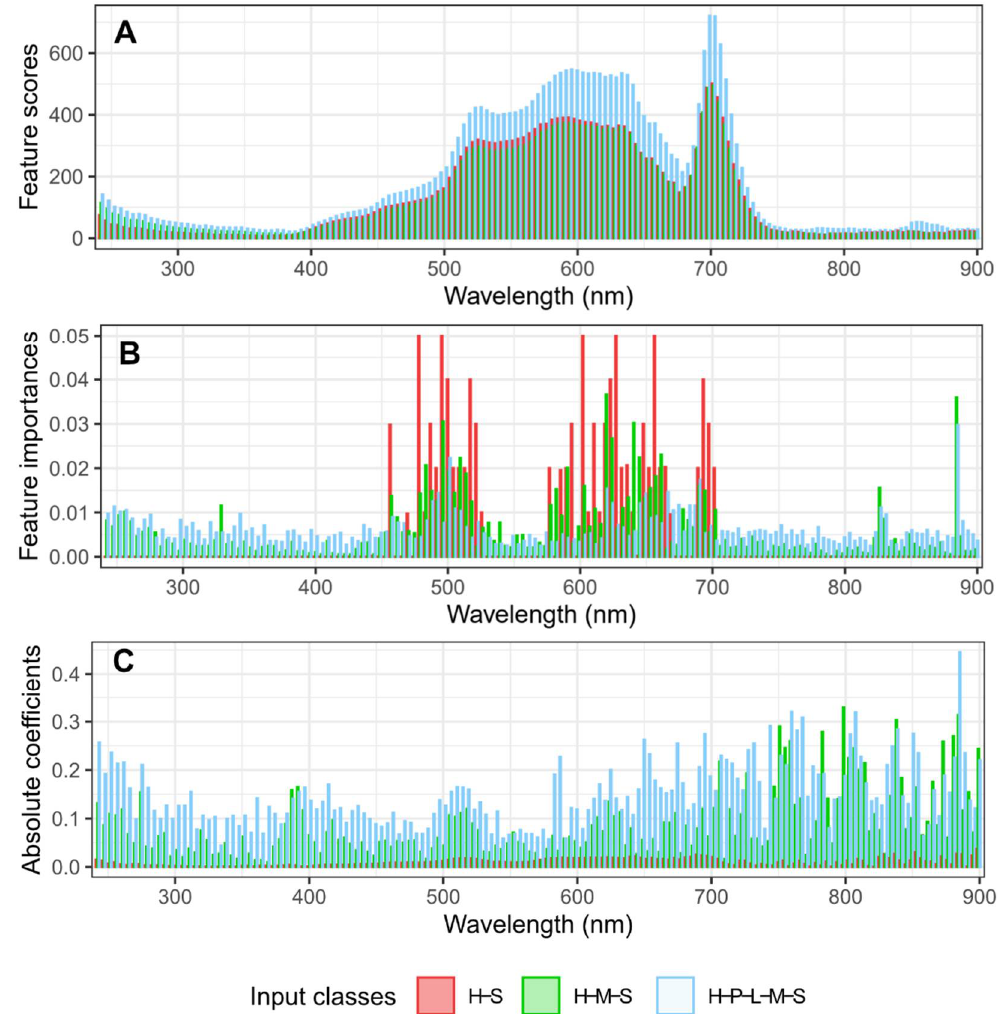
Figure 4. The weights of each feature/wavelength calculated by three different machine learning algorithms for the classification of peanut stem rot models. ( A ) The chi-square method; ( B ) Random forest; ( C ) Support vector machine with a linear kernel. H = ‘Healthy’, mock-inoculated control with no symptoms; P = ‘Presymptomatic’, inoculated with no symptoms; L = ‘Lesion only’, inoculated with necrotic lesions on stems only; M = ‘Mild’, inoculated with mild foliar wilting symptoms ( ≤ 50% leaves symptomatic); S = ‘Severe’, inoculated with severe foliar wilting symptoms (>50% leaves symptomatic).